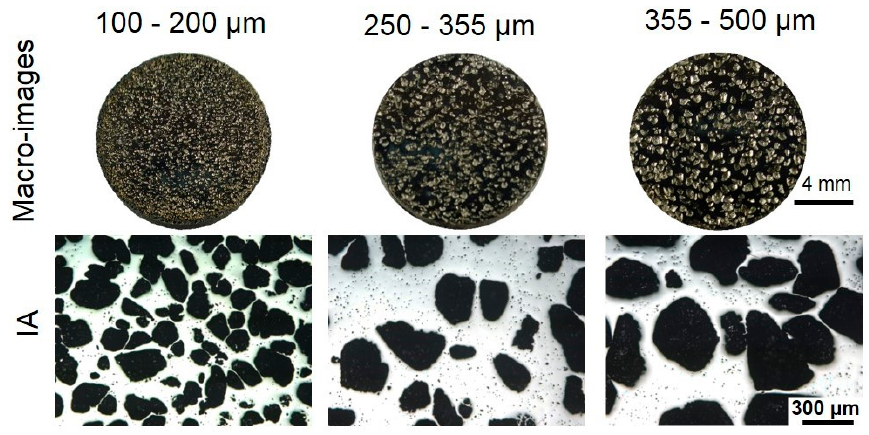
Figure 3. Macro-photography of the samples and optical microscopy images of the porous substrates for the di ff erent ranges of spacer particles size: 100 − 200 µ m, 250 − 355 µ m, and 355 − 500 µ m.